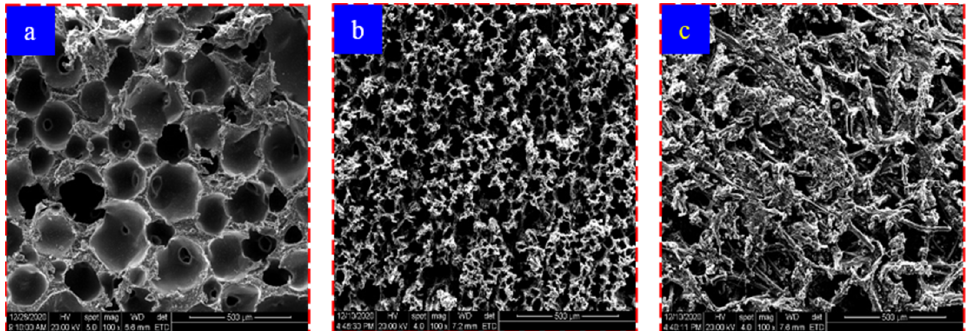
Figure 1. Polishing pad structures. ( a ) Polyurethane polishing pad. ( b ) Non-woven polishing pad. ( c ) Double-layer composite polishing pad.